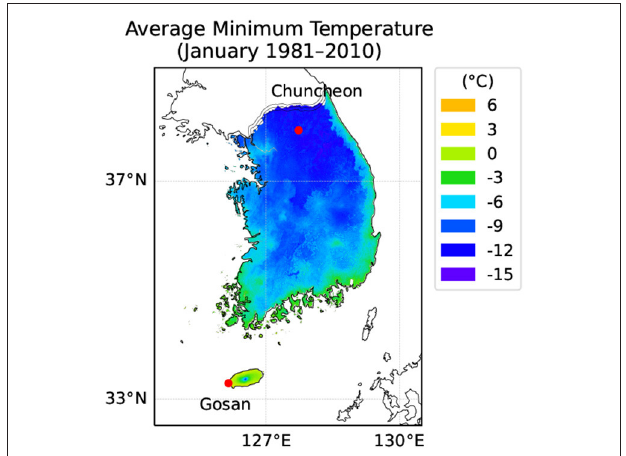
FIGURE 3 | Geographic locations of Gosan and Jeju in South Korea. Gosan is located on a Southern island with a humid subtropical climate off the Korean peninsula. Chuncheon is located in the middle of the peninsula with a humid continental climate with cold winter. A color overlay represents the average minimum temperature ( ◦ C) in January during past 30 years from 1981 to 2010 provided by the National Institute of Agricultural Sciences, South Korea. According to USDA Hardiness Zones, Gosan is Zone 9b and Chuncheon is Zone